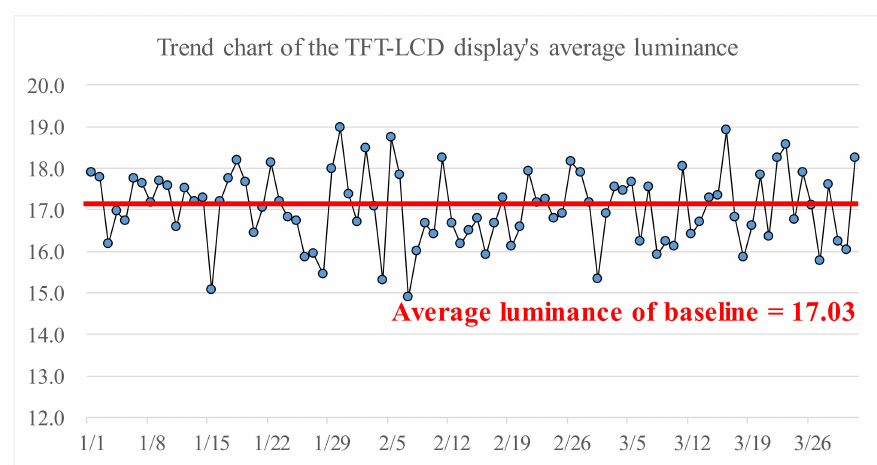
Figure 4. Trend chart of the TFT-LCD display’s average